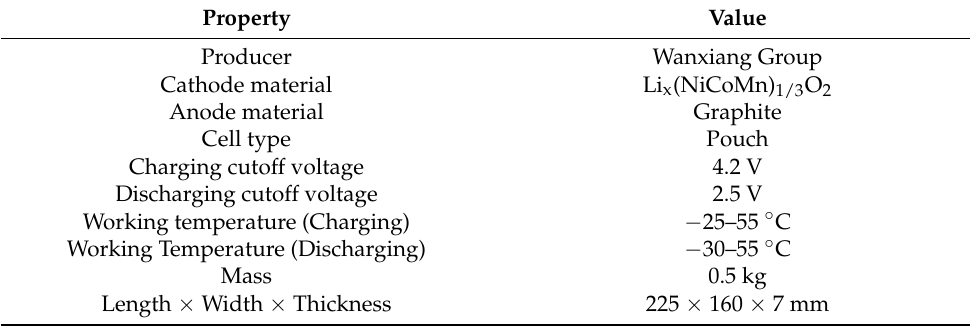
Table 1. Detailed information of the large-capacity batteries used in this study.